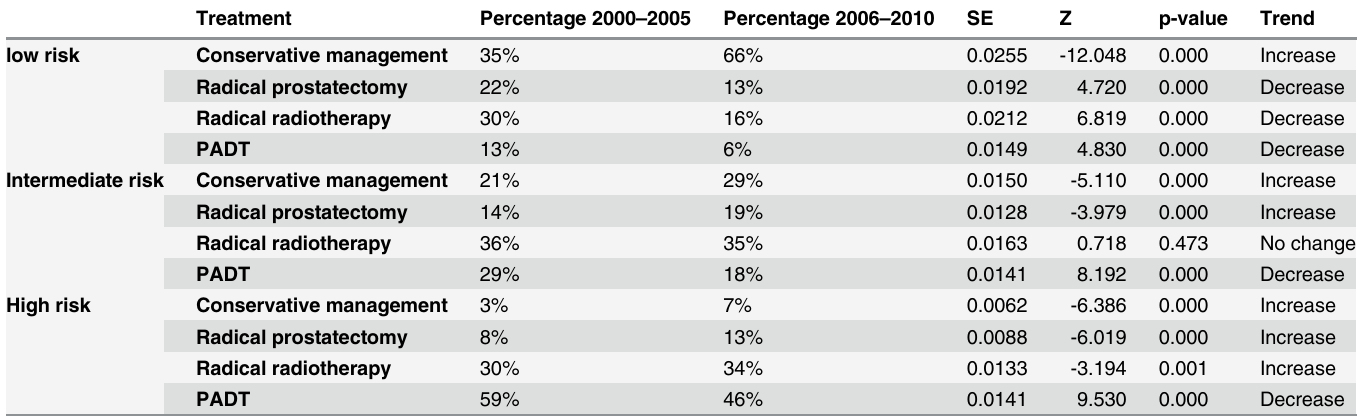
Table 2. Incidence rate changes in prostate cancer treatment modality for non-metastatic disease strati fi ed by NICE risk group between 2000 – 2005 and 2006 – 201.